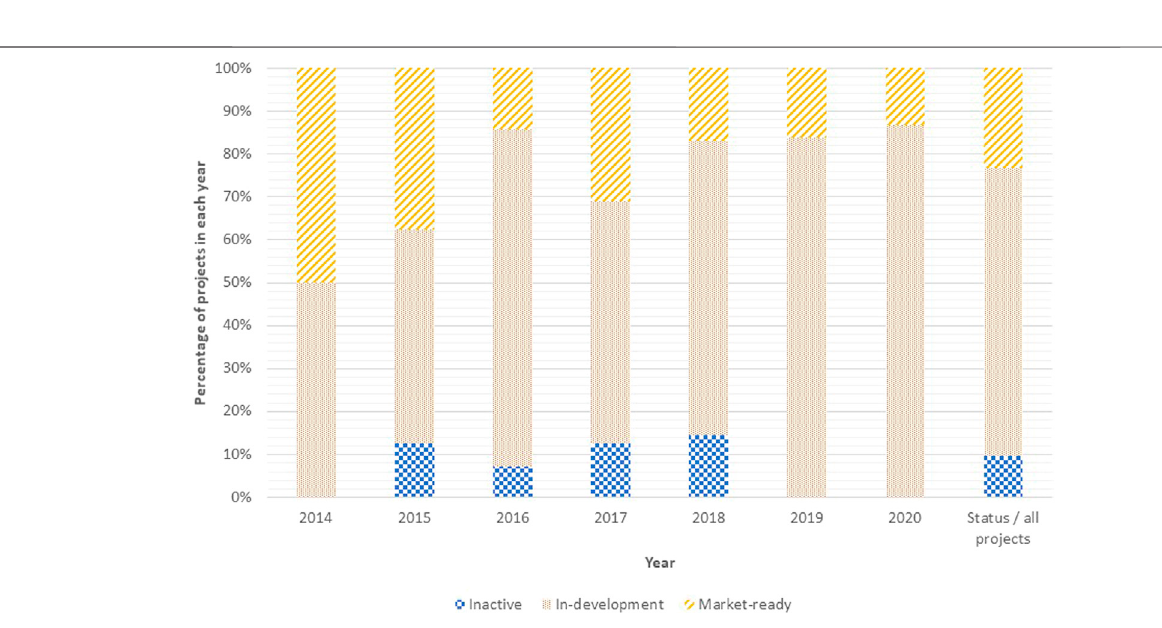
Frontiers in Blockchain |